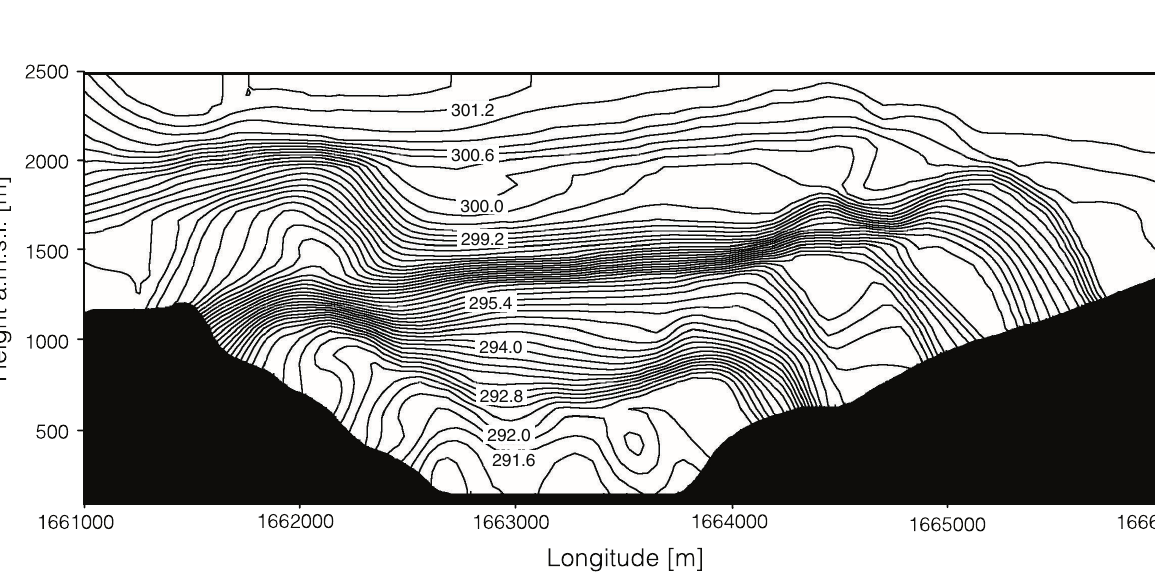
over a valley cross-section (over Besenello fi g. 5) from v